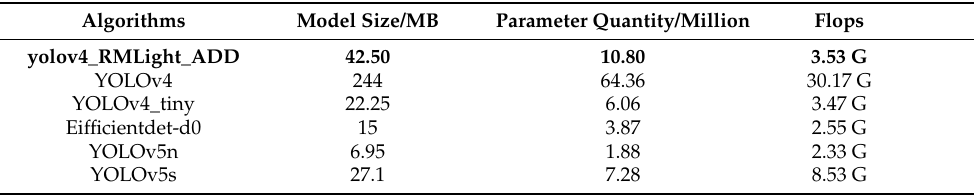
Table 7. Performance results for different detection